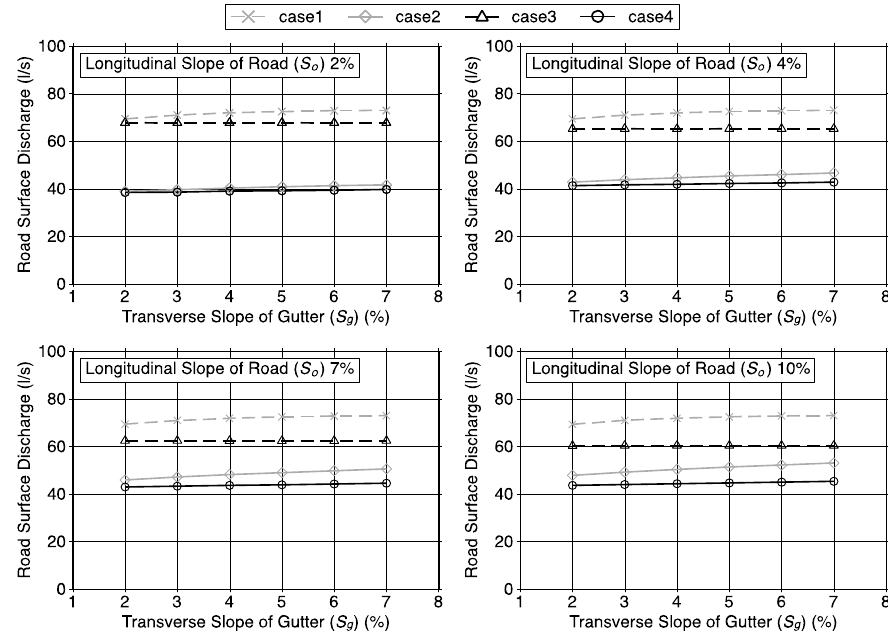
Figure 6. Road surface discharges due to different transverse slopes of the gutter.